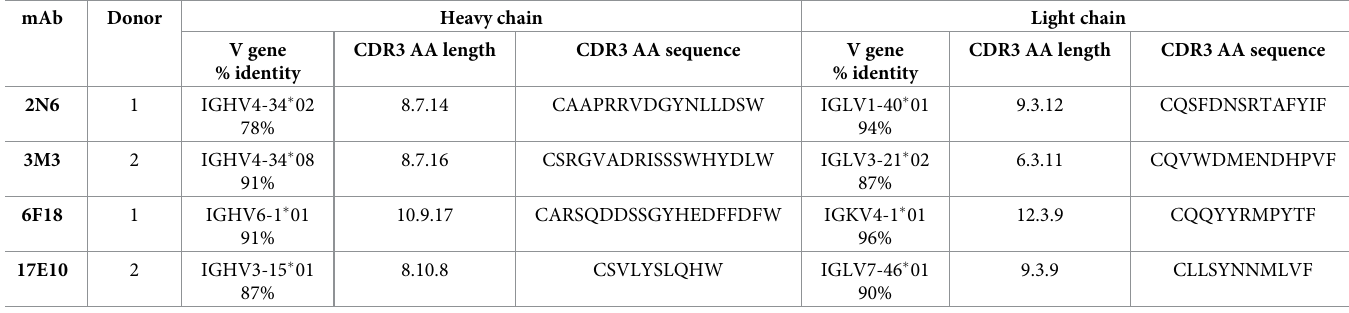
Table 2. Antibody sequence analysis for the V gene usage and CDR3